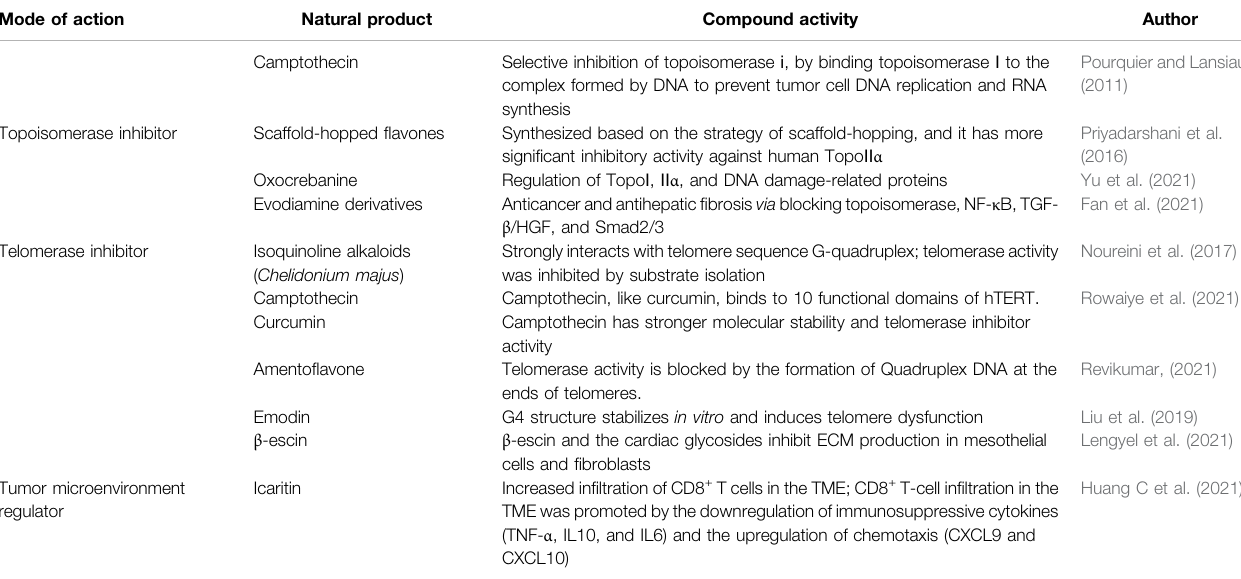
TABLE 7 | ( Continued ) List of anticancer natural product classi fi cations based on pathways of